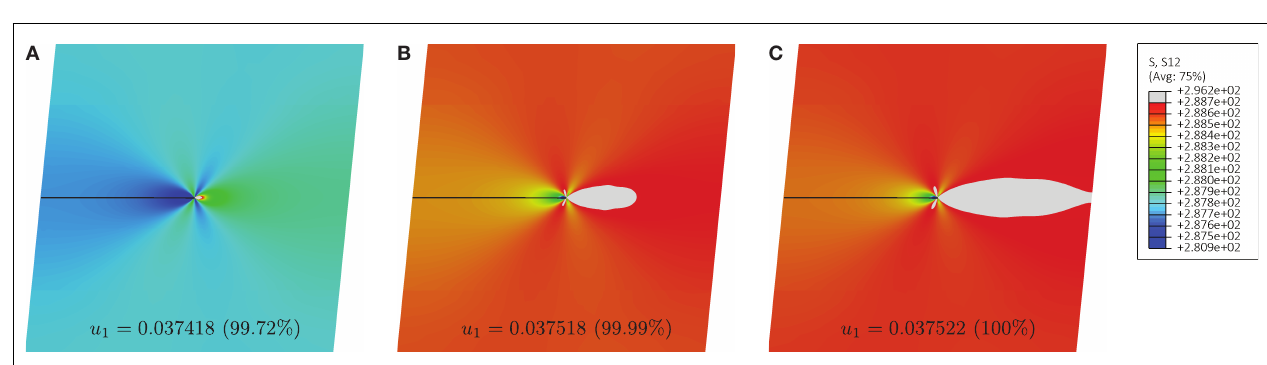
displacement at the upper edge of the square domain u 1 = 0.037418mm FIGURE 6 | Contour plots of the shear stress σ 12 for the case of material far from shear band instability ( E p = 150000MPa) .The gray region (A) , u 1 = 0.037518mm (B) , u 1 = 0.037522mm (C) .The displacements in the √ corresponds to the material at yielding σ 12 ≥ 500 / figures are amplified by a deformation scale factor of 25 and the percentages 3 = 288.68 MPa .Three refer to the final different stages of deformation are shown, corresponding to a prescribed